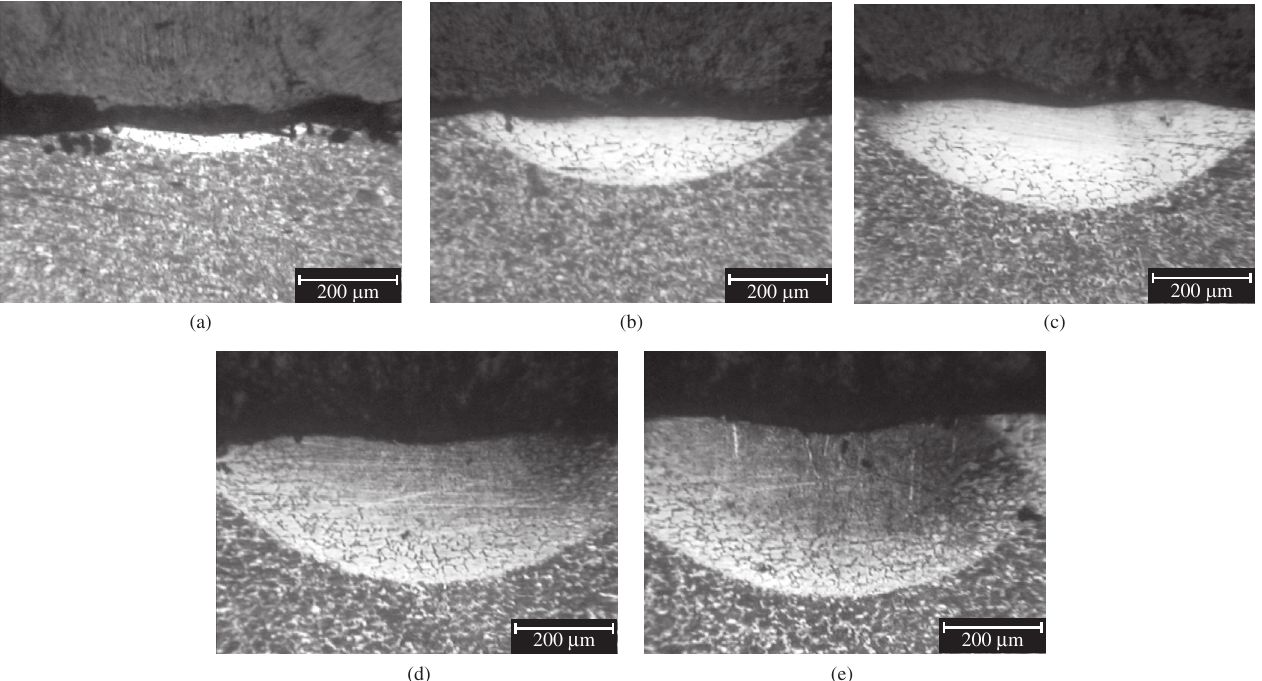
Figure 2. Micrographs of laser heat tracks inside the steel (transversal cuts) for different power levels: a) 300 W; b) 500 W; c) 700 W; d) 900 W; and e) 1100